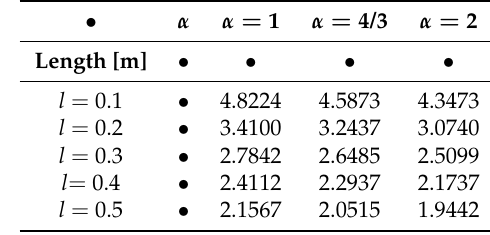
Table 3. Second mode frequency ω 2 (Hz).